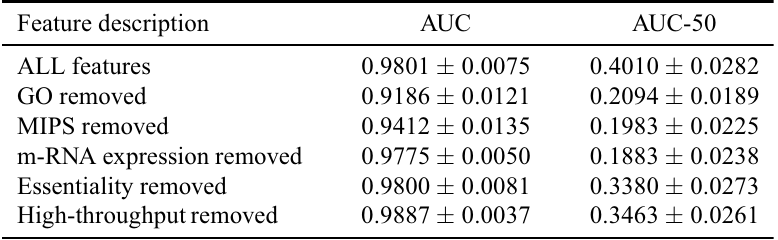
Table 2: Evaluation of the individual effect of the different biological attributes in the performance of the OCC parzen